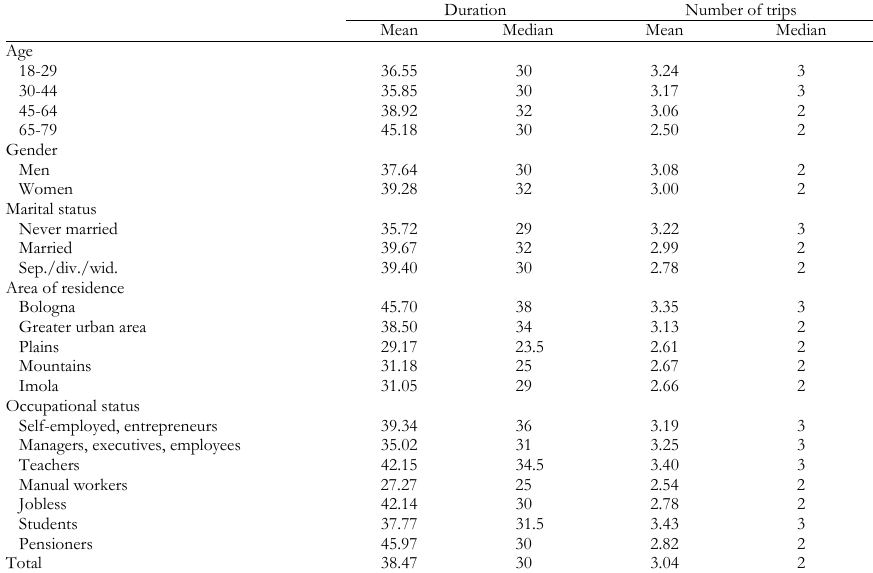
Mean and median durations for the longest holiday and number of (long) holidays during 2003-2004. Sub-sample of holidaymakers (individuals that took at least one long holiday)